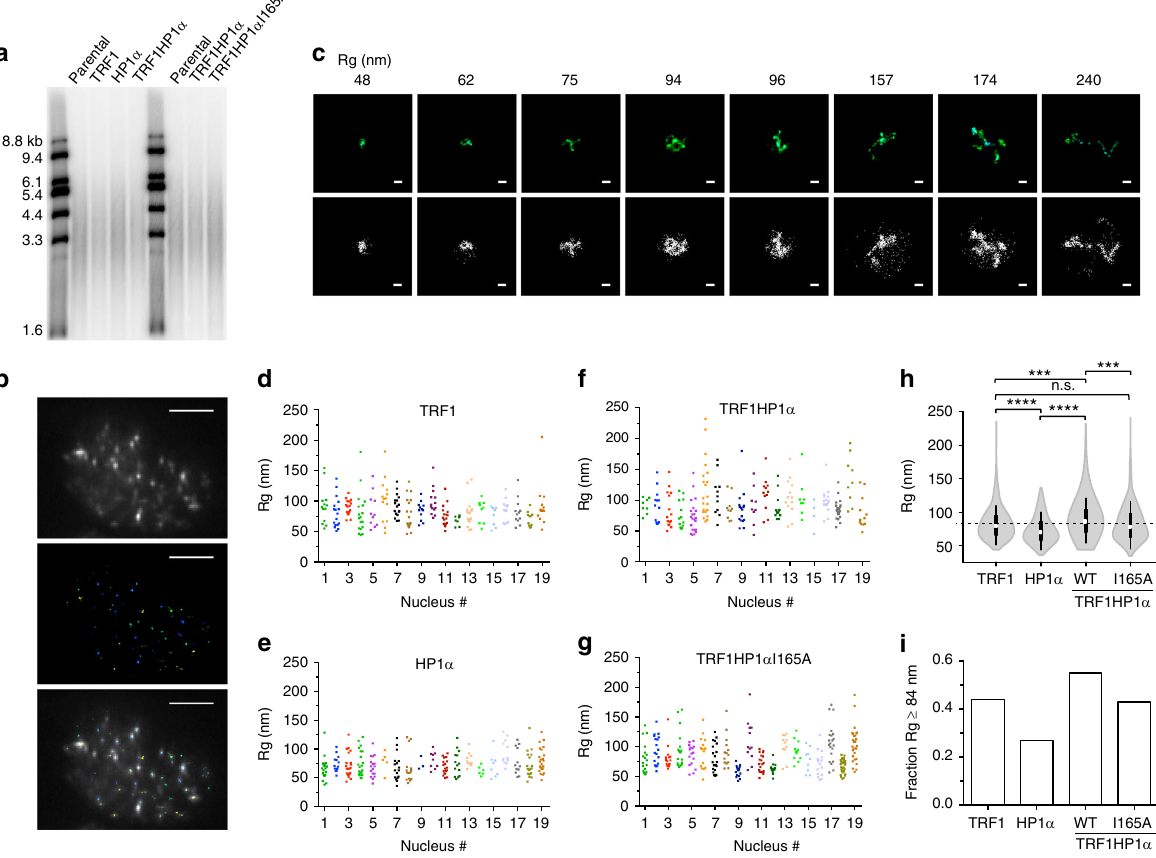
Fig. 6 TRF1HP1 α increases the fraction of irregular-shaped telomeres analyzed by STORM. a Similar telomere length (average and length distribution) across TRF1HP1 α , I165A and control groups (TRF1, HP1 α ) at the time of analysis. b Top: Wide fi eld conventional fl uorescence image of representative UM- UC3 nucleus hybridized with Cy5-end-labeled C-strand telomeric PNA FISH probe. Images acquired contain ~35,000 frames with a z-depth-range of ~700 nm. Middle: the corresponding STORM image. Bottom: Overlay of conventional and STORM images. Bar: 5 µ m. c Top: Representative reconstructed single telomere STORM images of TRF1HP1 α and each corresponding Rg (nm) across a gradient. Bottom: Corresponding raw images of individual signal localization spots (displayed as dots) prior to image processing and reconstruction. Bar: 100 nm. d − g Rg of individual telomeres (dots) in 19 nuclei analyzed for each group d TRF1, e HP1 α , f TRF1HP1 α or g TRF1HP1 α I165A. Y -axis: Rg (nm). X -axis: nucleus index. Each individual nucleus is distinguished by a different color. Each dot corresponds to one telomere. h Distribution of Rg (nm) represents as a violin plot showing frequency (width of density plot), median (white dot), interquartile range (bar), and 95% con fi dence interval (line). TRF1 ( n = 38 nuclei, 437 telomeres), HP1 α ( n = 19 nuclei, 264 telomeres), TRF1HP1 α ( n = 47 nuclei, 552 telomeres), and TRF1HP1 α I165A ( n = 27 nuclei, 451 telomeres). Means of Rg are compared using ANOVA Tukey ’ s multiple comparisons with 95% con fi dence level **** p < 0.0001; left *** p = 0.0003; right *** p = 0.0001; n.s. (no signi fi cance). Mean of TRF1 Rg (84 nm) indicated as cut-off (dashed line) and i fractions of Rg equal or greater than the 84 nm cut-off in experimental